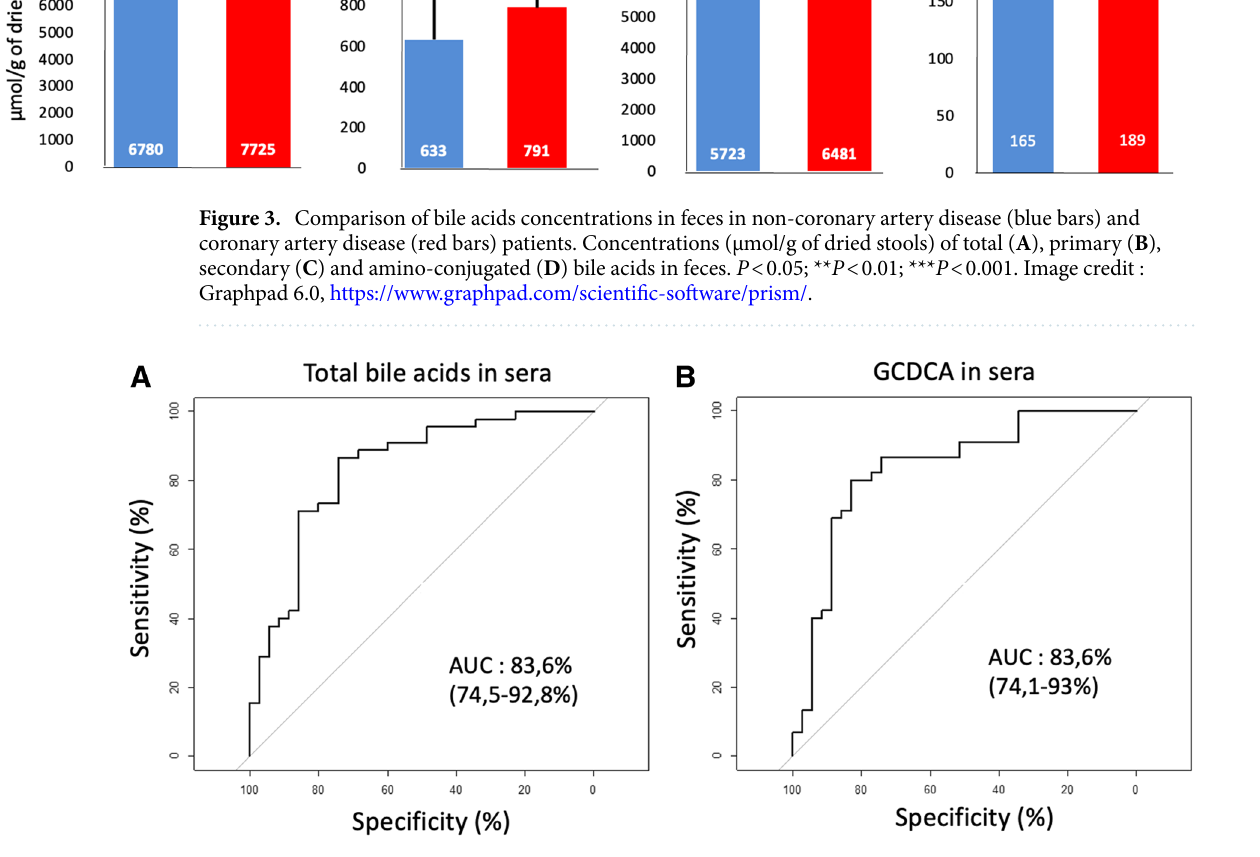
Figure 4. Receiver operating characteristic curves using as predictive factors of coronary artery disease adjusted for age and gender: ( A ) total bile acids concentrations in sera; ( B ) glycho-chenodeoxycholic acid (GCDCA) in sera. Image credit: R software: https:// www.r- proje ct.